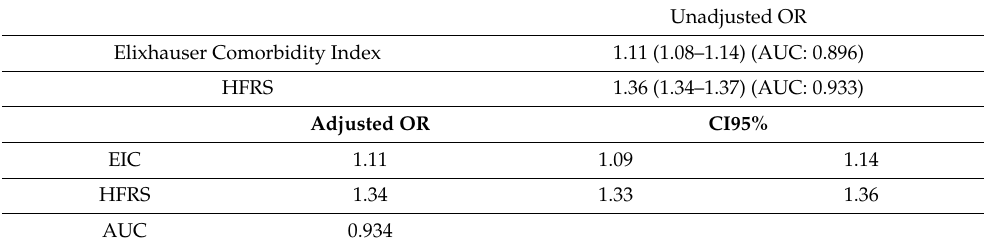
Table 5. Adjusted and Unadjusted Multivariable logistic models for the incidence of postoperative sepsis for Elixhauser Comorbidity Index and HFRS and predictive capacity estimated by Area Under the Curve of the different models.